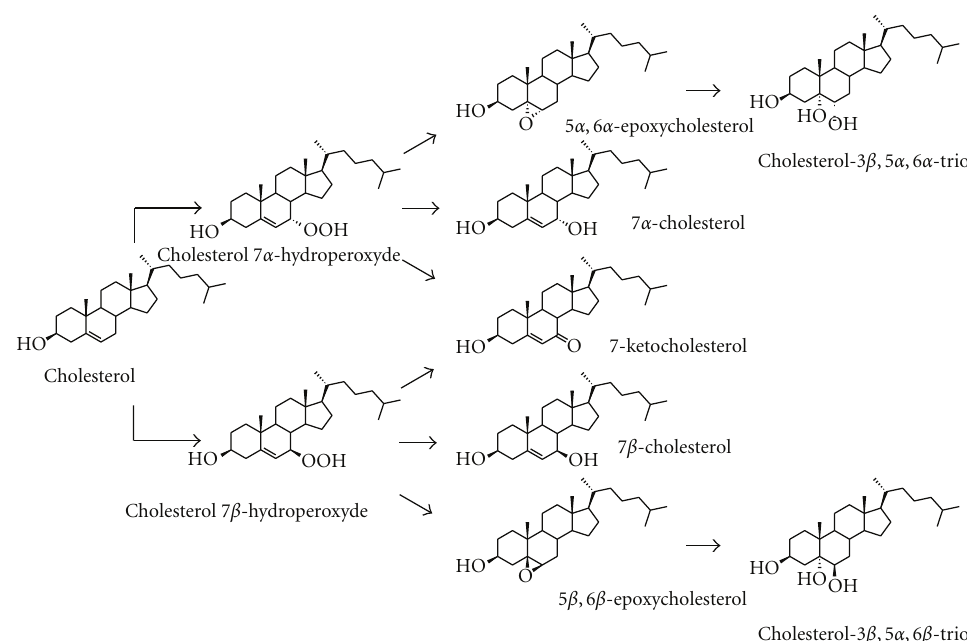
Figure 1: Cholesterol autoxidation. Autoxidation of cholesterol can generate 7 α - or 7 β -hydroperoxyde, 7 α - or 7 β -hydroxycholesterol, 7-ketocholesterol, 5 α , 6 α - or 5 β , 6 β -epoxycholesterol, as well as cholesterol 3 β , 5 α , 6 β triol or cholesterol 3 β , 5 α , 6 α triol depending on pH